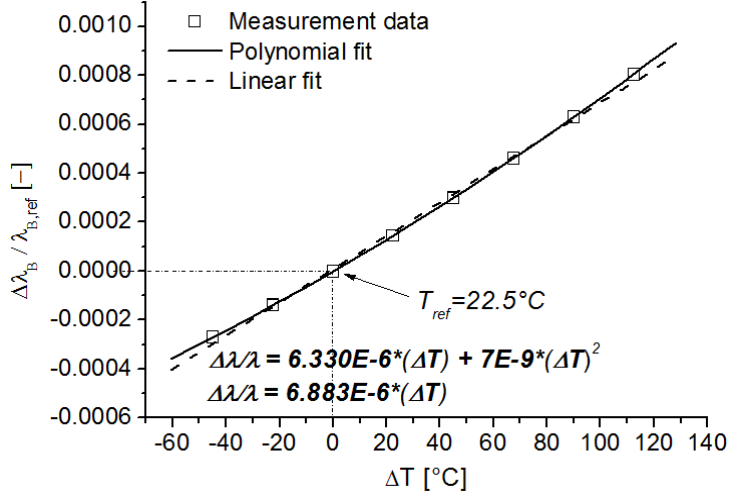
Figure 3. Temperature calibration (ranging from − 22.5 °C–135 °C) of an FBG written in a Ge-doped optical